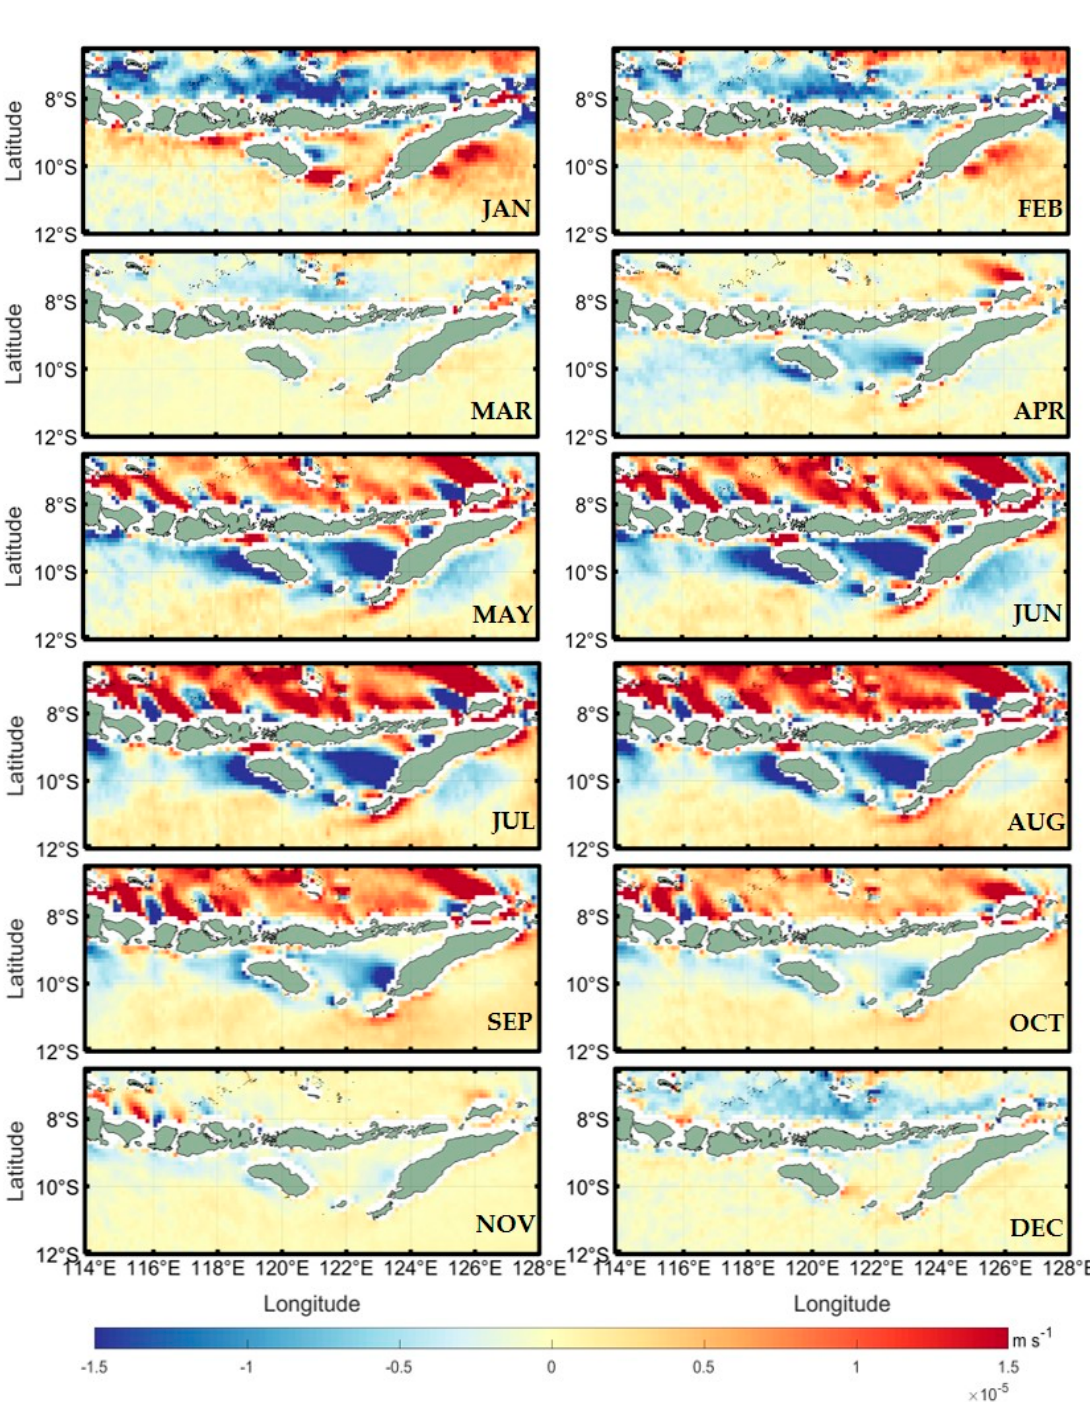
Figure 9. The climatological monthly mean values of Ekman Pumping Velocity (EPV) during 2007–2020.